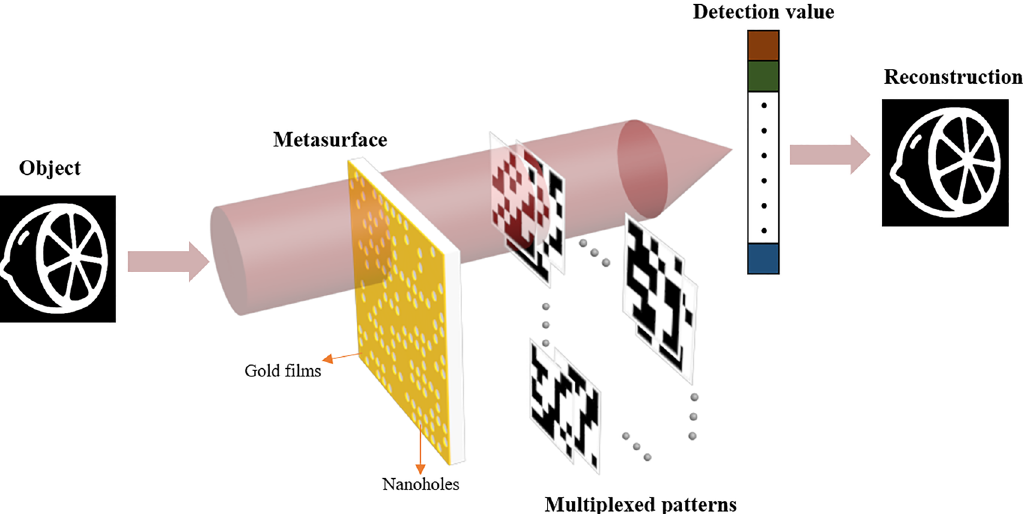
Figure 1: Schematic illustration of metasurface composed of photon sieves and SPI reconstruction. When shifting the metasurface in x and y direction, it can produce different patterns through delicate arrangement of photon sieves and achieve multiplexed patterns. Meanwhile, the intensities with target information are collected by a single pixel detector. Then, the target image is reconstructed by SPI